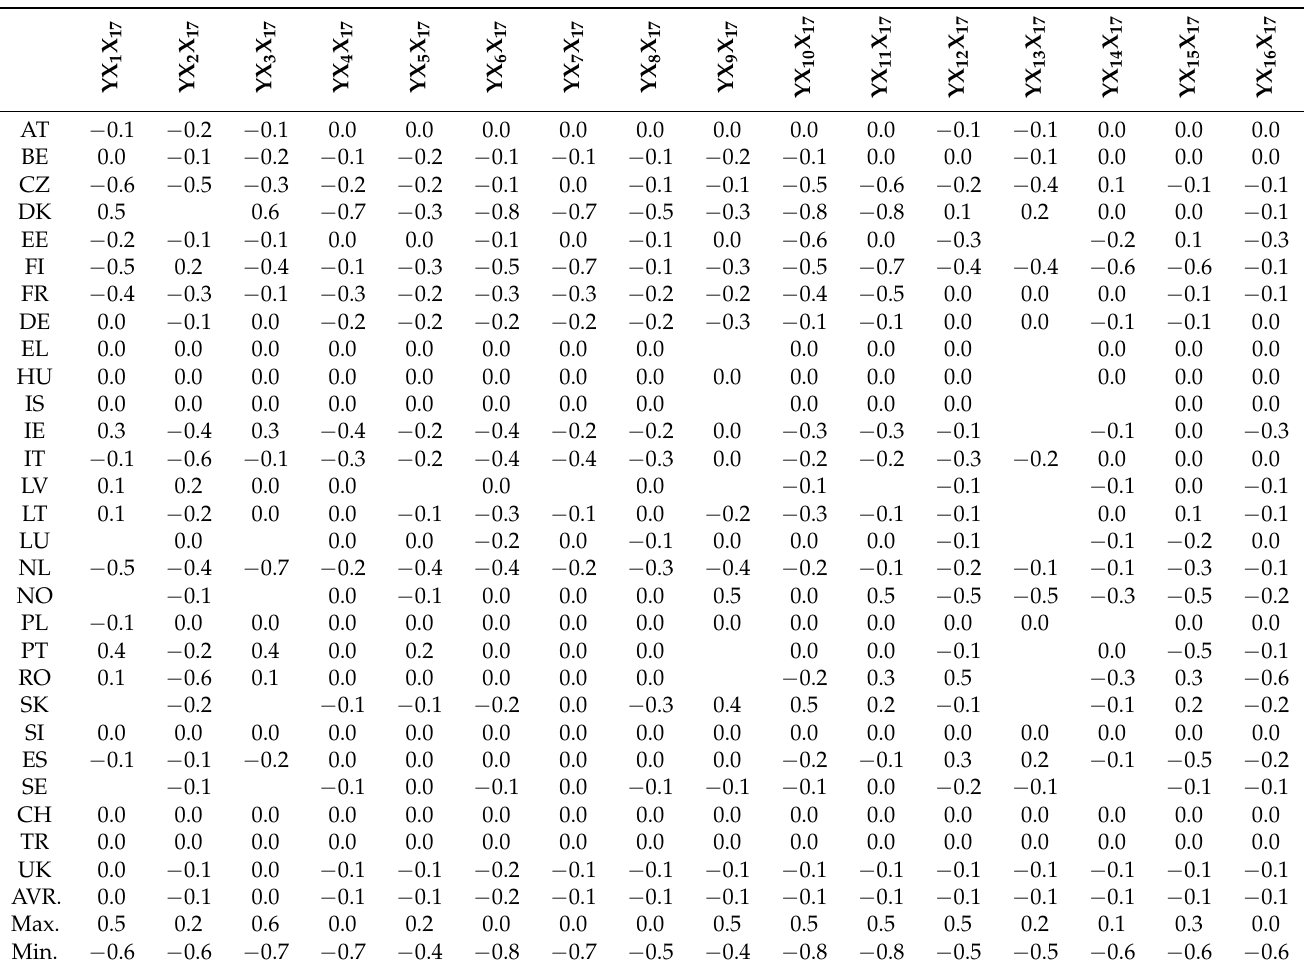
Table 11. Tri-dimensional synergy—YX i X 17